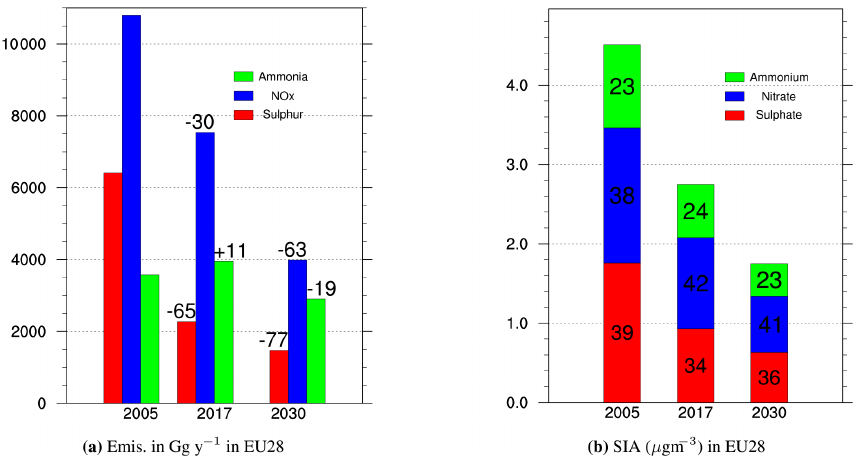
Figure 1. (a) Emissions of SO x as SO 2 , NO x as NO 2 , and NH 3 summed up for the EU28 countries. Percentage change in emissions from 2005 is given above the bars. (b) Concentrations of SIA (µgm − 3 ) split into sulfate (SO 2 − averaged over the EU28 countries. Percentage contributions to SIA are printed inside the